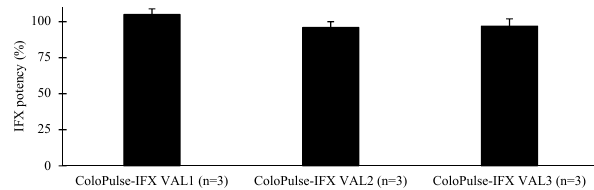
Figure 4. The average ± SD ( n = 3) potency of IFX present in ColoPulse-IFX compared to 5 mg fresh IFX stock (100%) as analyzed with a validated ELISA kit.